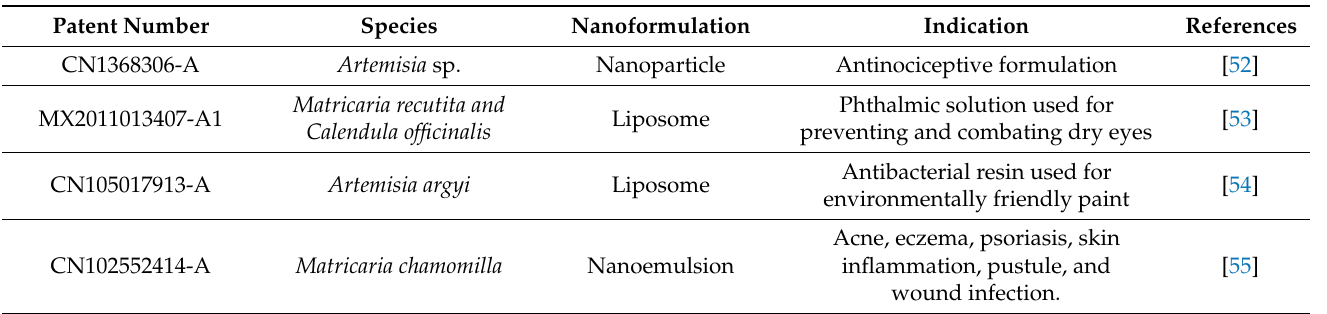
Table 6. Nanoproducts patents from Asteraceae